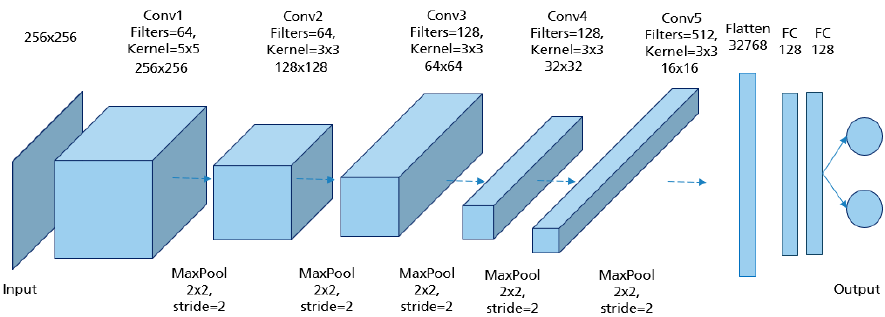
Figure 23. Model architecture of the implemented CNN for assessment of the nipple position with the best performance.